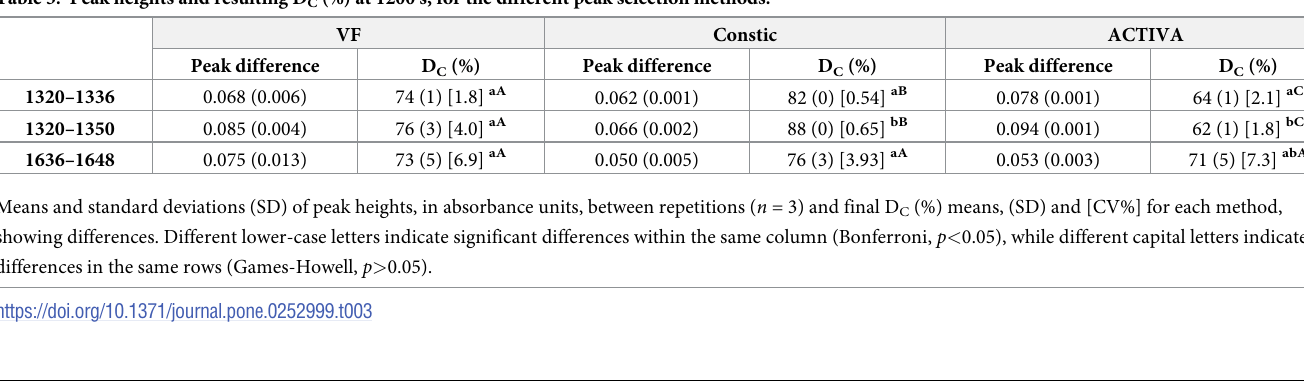
Table 3. Peak heights and resulting D C (%) at 1200 s, for the different peak selection methods. VF Constic ACTIVA